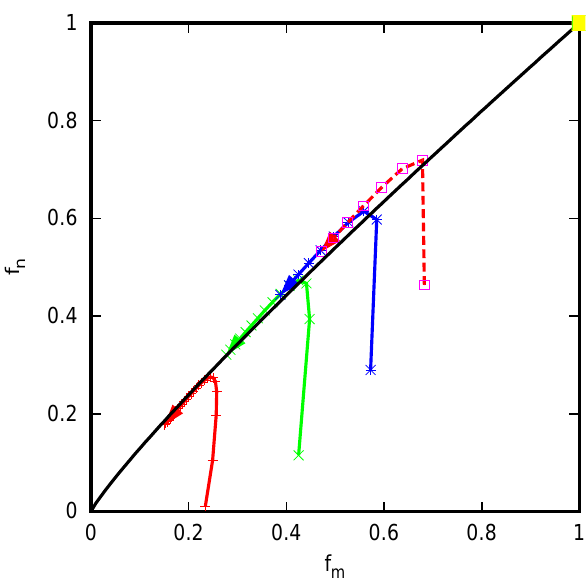
Fig. 3. Mass loss ( f m ) and number loss ( f n ) fractions for series of subsequent sublimation time steps. Time steps are 100, 200, 300, 400 s (solid red, green, blue, dashed red), and time runs along each curve from the point neares to the f m –axis to the point nearest to the f n –axis. The individual time steps are marked on each curve. Arrows indicate the direction of time. The yellow point at (1 , 1) was the result of a test with a very long time step that should guarantee that the ice sublimates completely within that step. The black line is the attempt of a fit of the later parts of the curves, f n = f 0 . 89 m . The initial geometric mean mass for the calculations is m 0 =1 ng.